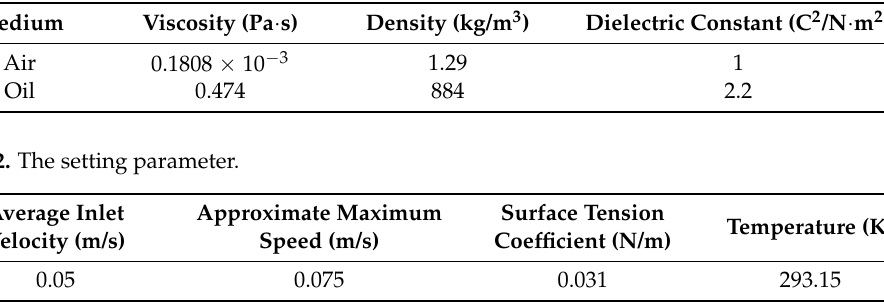
Table 1. The medium information setting in simulation process.